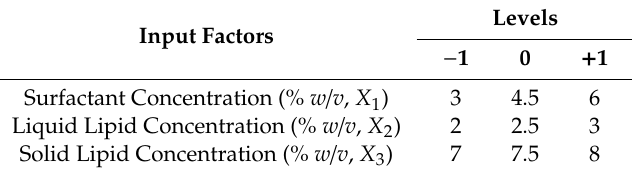
Table 1. Input factors and their levels for Box-Behnken